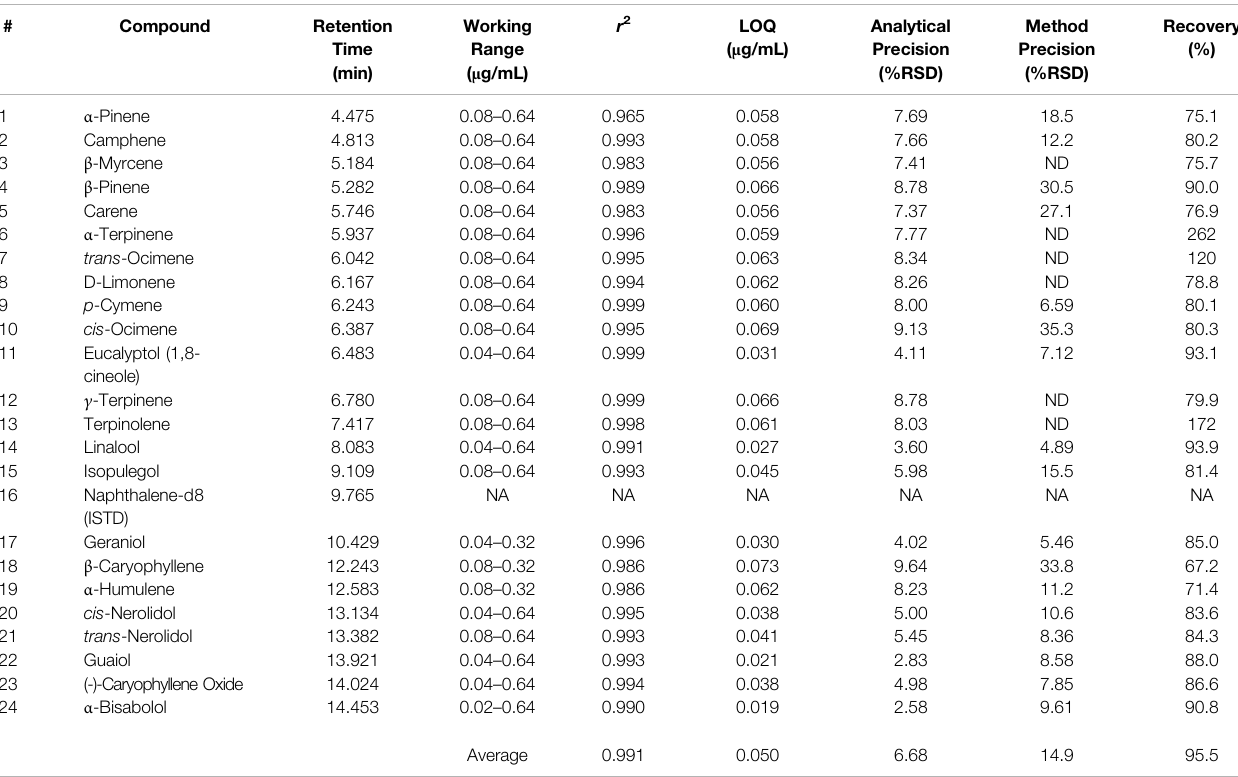
TABLE 5 | DI-SPME Arrow – GC-MS method validation with ASE extracted cleaned hops matrix match for